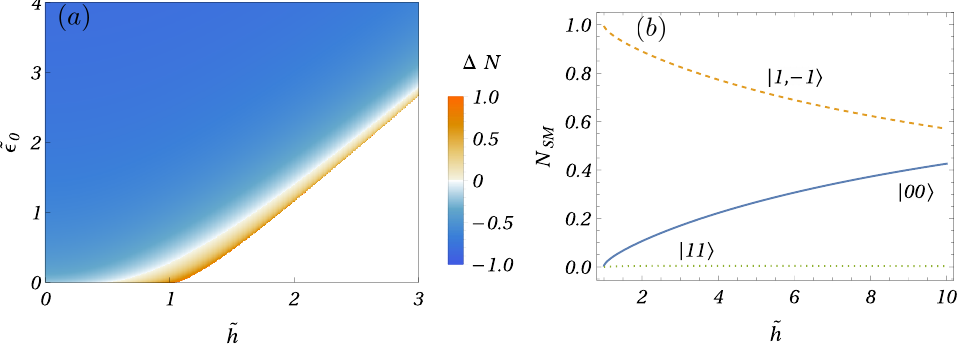
Figure 3: Triplet-state admixture to 2D-fermion bound states with zero center- of-mass momentum. The color scale in panel (a) visualizes the difference ∆ N = (cid:80) − N N between the combined fractional weights of triplet states con- 1 M 00 M tributing to the dimer and that of the singlet-state contribution. Panel (b) shows = 0) for total-spin eigenstates in bound states formed plots of N (except for N SM 10 ) ≡ ( ˜ h crit , ˜ ε crit ) corresponding to the solid blue for parameter combinations ( ˜ h , ˜ ε 0 0 [ ˜ h crit ] given by Eq. (51) [ by inverting Eq. (51) ] line shown in Fig. 1(a), with ˜ ε crit 0